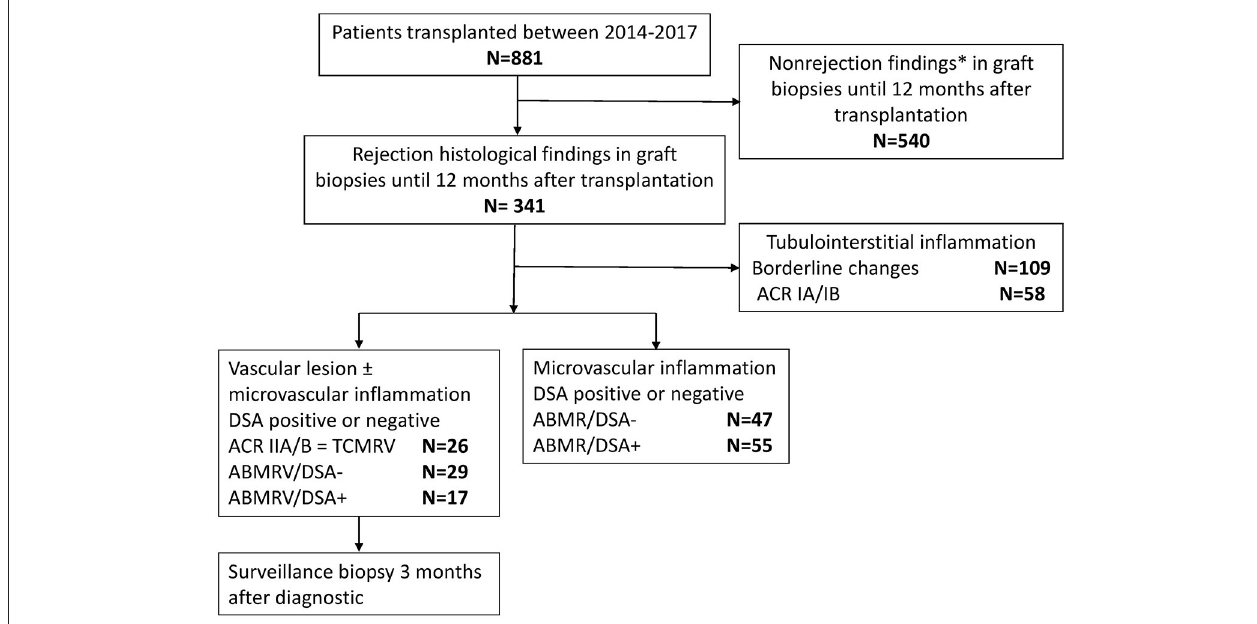
FIGURE 1 | Study flowchart. * Including parainfectious changes, tubulointerstitial inflammation in the presence of BKV, and suspected recurrence of